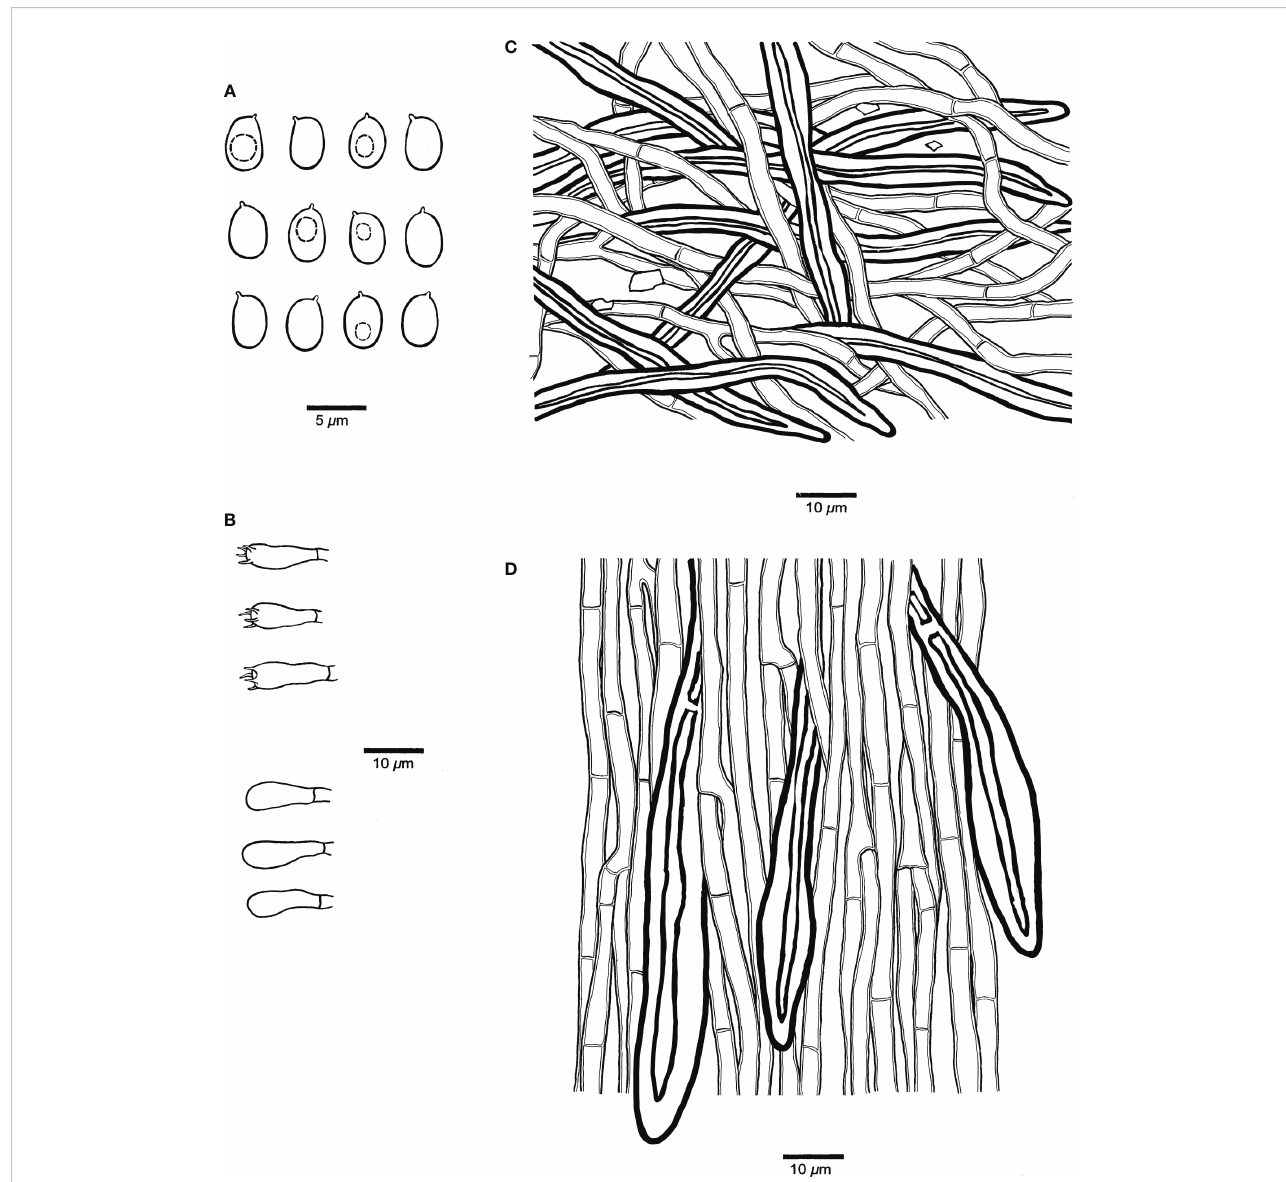
FIGURE 6 Microscopic structures of Pyrrhoderma nigra (holotype, Cui 8546). (A) Basidiospores. (B) Basidia and basidioles. (C) Hyphae from subiculum. (D) Hyphae from tube